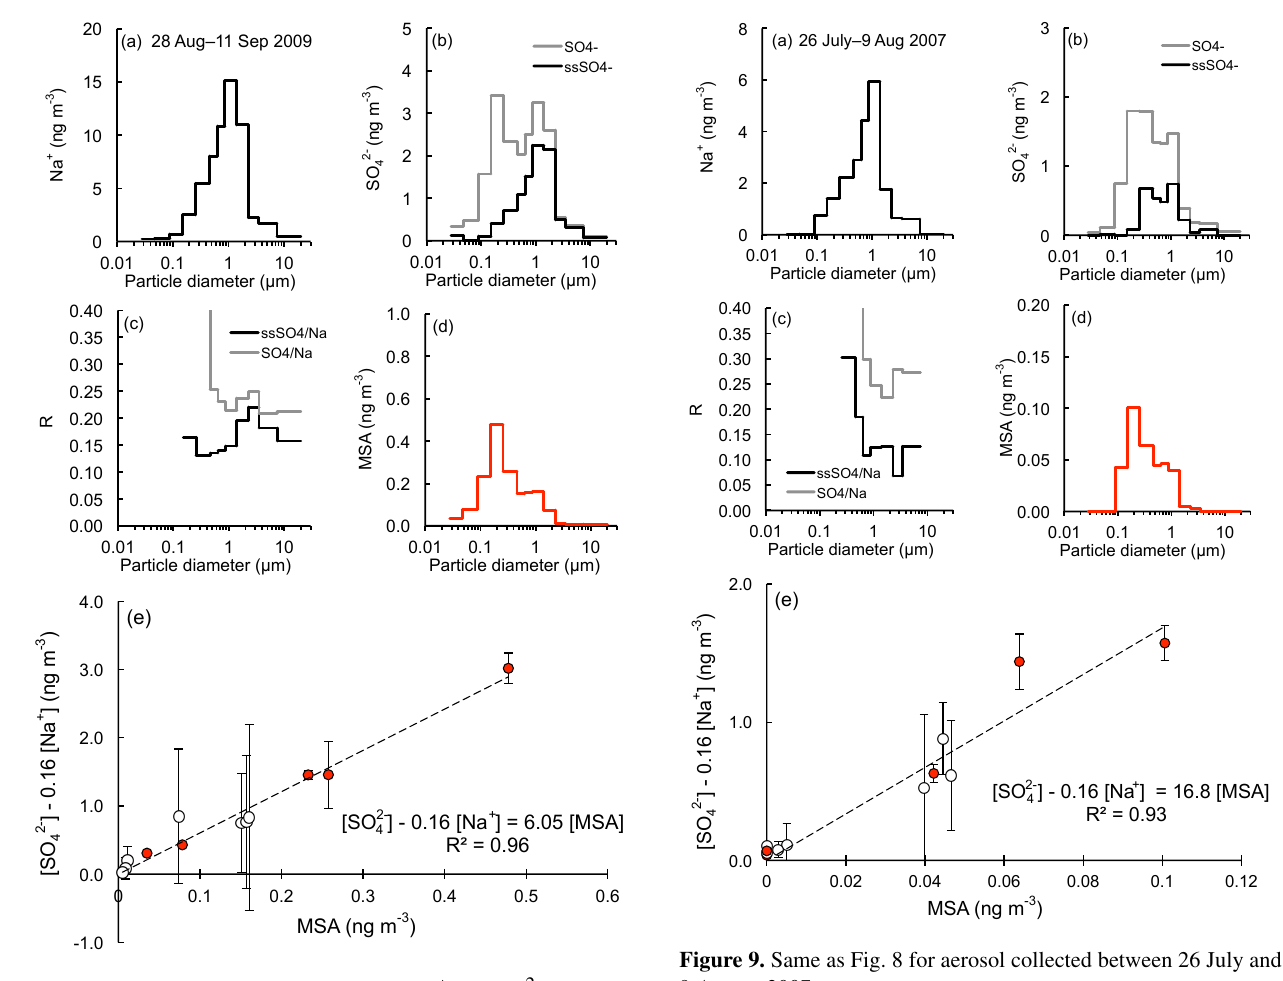
between 0.25 (if no fractionation with respect to the